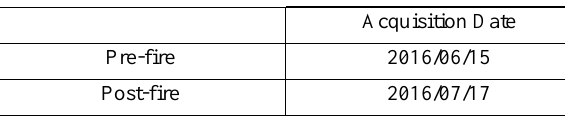
Table 2: pre-/post-fire images applied in this study